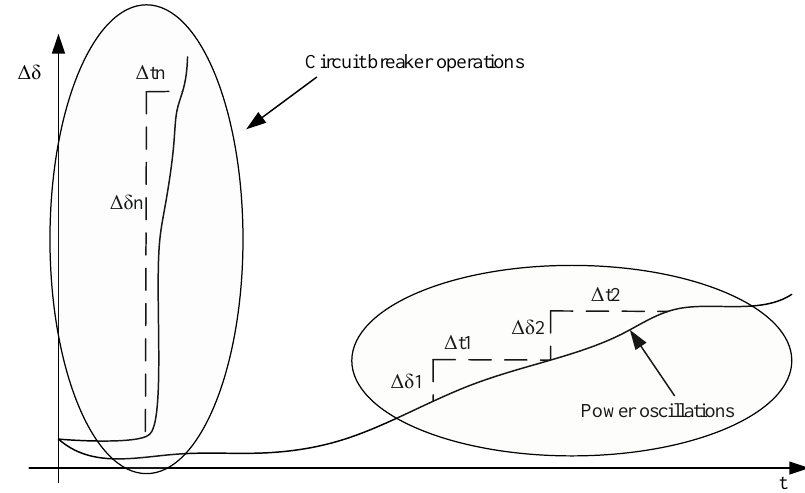
Figure 6. Trajectory path for circuit breaker switching operations or short circuit faults and some trajectory path for possible active power oscillations on a single transmission line.